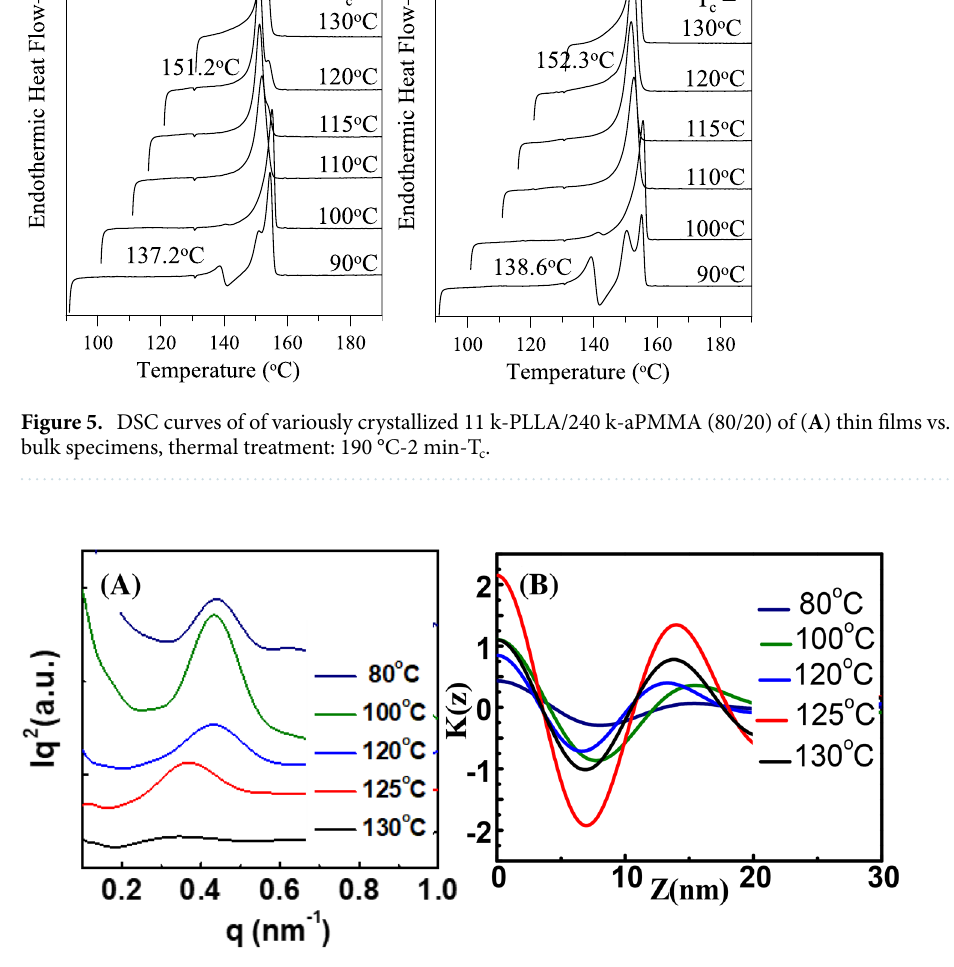
Figure 6. ( A ) 1D-SAXS results for the lamellae variation in PLLA spherulite of PLLA/PMMA (80/20) crystallized at T c = 80 °C, 100 °C, 120 °C, 125 °C, and 130 °C, respectively, and ( B ) 1-D electron density correlation function estimated from SAXS data. (sample thickness = 5